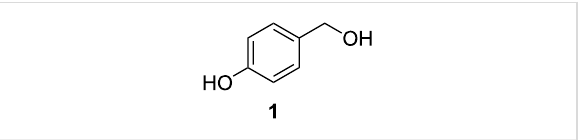
Figure 1: Structure of 4-hydroxybenzyl alcohol (HBA, 1 ).